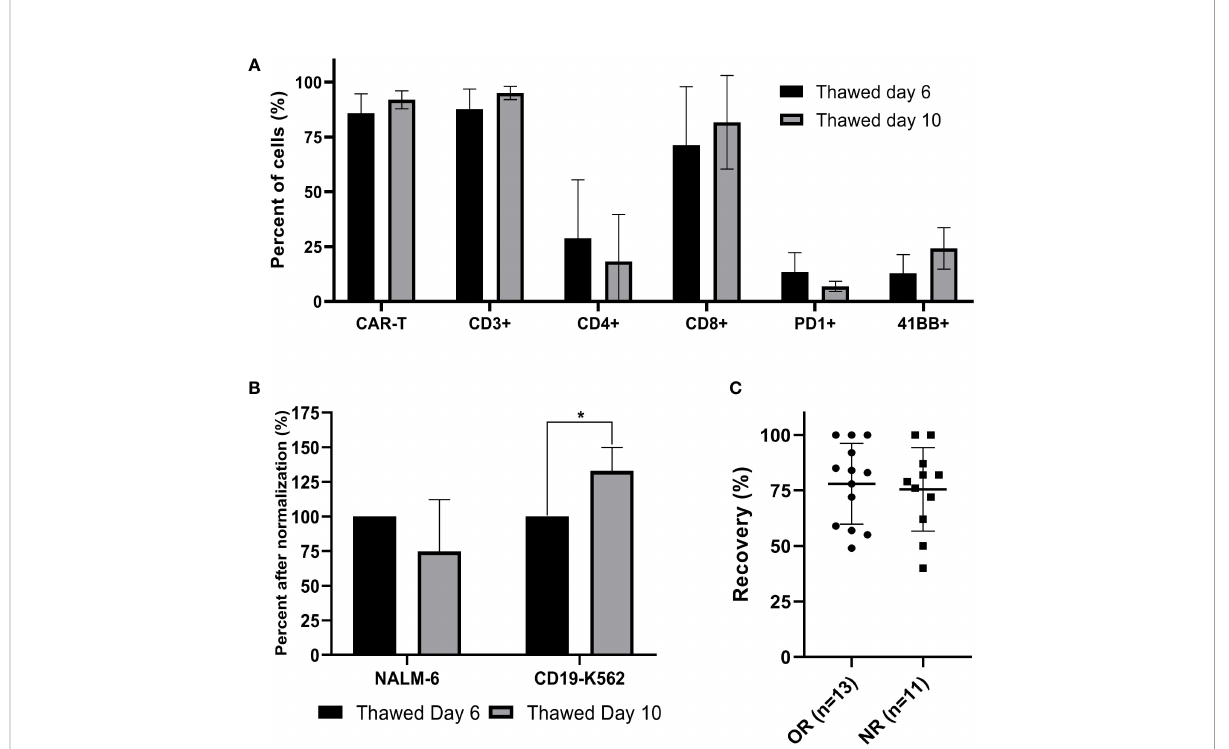
FIGURE 4 Comparison of cryopreserved infusion products from day 6 and day 10 and correlation between cell recovery and clinical response. (A) Thawed CAR T cells from day 6 and day 10 were characterized by fl ow cytometry (n=3). (B) Cell potency of thawed CAR T cells from day 6 and from day 10, determined by IFN g secretion after co-culture with CD19 expressing target cell lines (NALM-6, CD19-K562). The IFN g levels are shown after normalization (thawed day 6 = 100%). (n=3); *p ≤ .01. (C) Spearman ’ s rho correlation between cell recovery (%) and clinical response (OR; objective responder; NR, non-responder). Each dot represents a single patient ’ s product. Bold lines represent median, with maximum and minimum range. P values were calculated for unpaired t